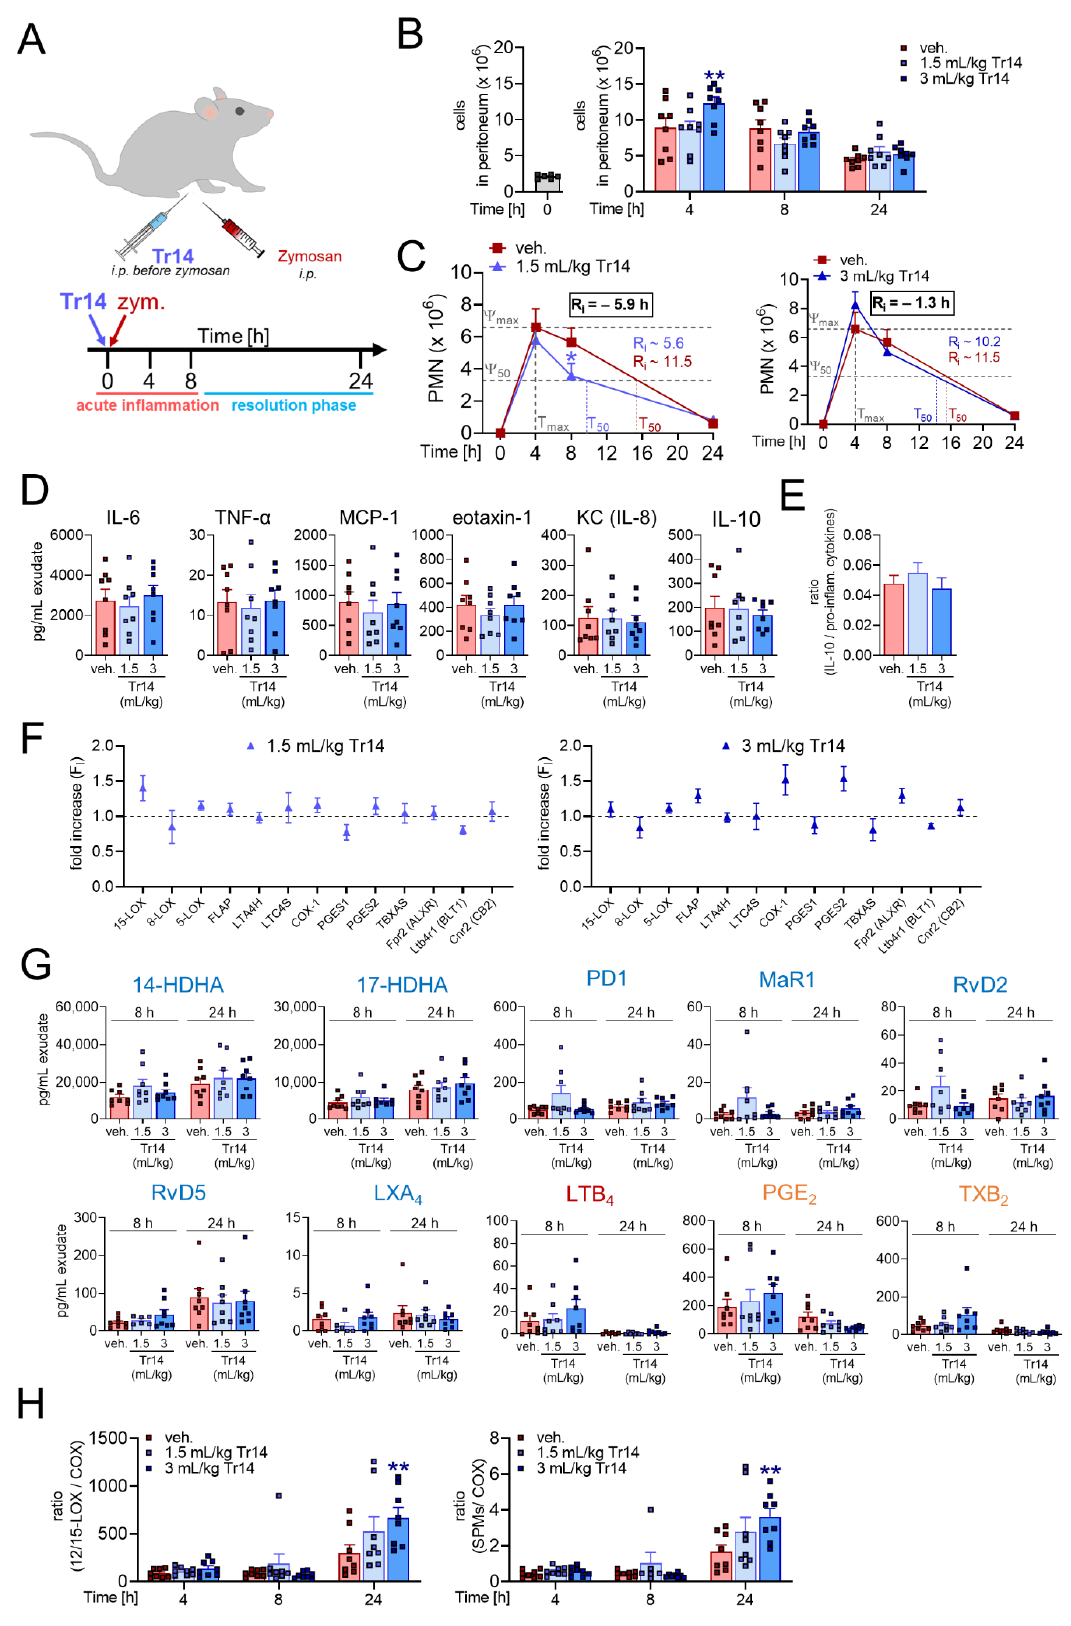
Figure 1. Effects of Tr14, pre-administered i.p. over 6 days prior murine peritonitis induction, on resolution of